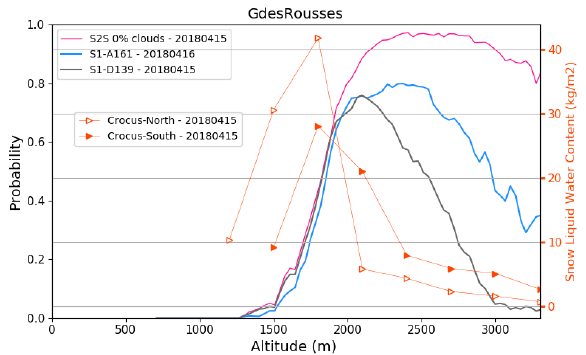
Figure 16. Snow probability curves as function of altitudes for mid-april 2018 obtained from FSC Sentinel-2 product (15 April 2018, pink curve), SWS ascending (16 April 2018, blue curve) and descending product (15 April 2018, grey curve). Snow liquid water simulated by Crocus for the southern and northern orientations are also shown in this figure (orange curves).